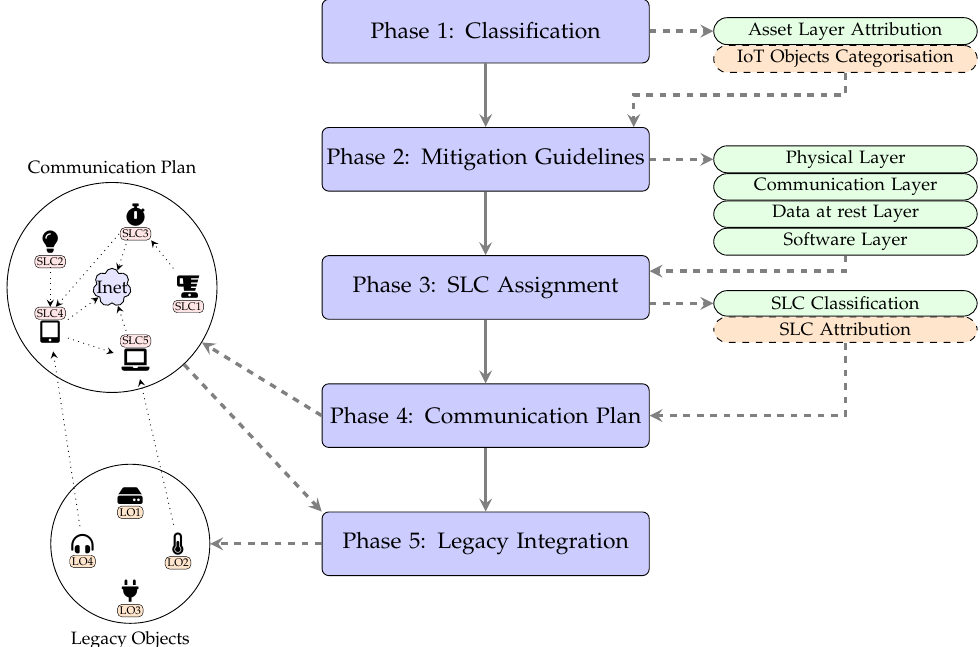
Figure 1. An overview of the proposed